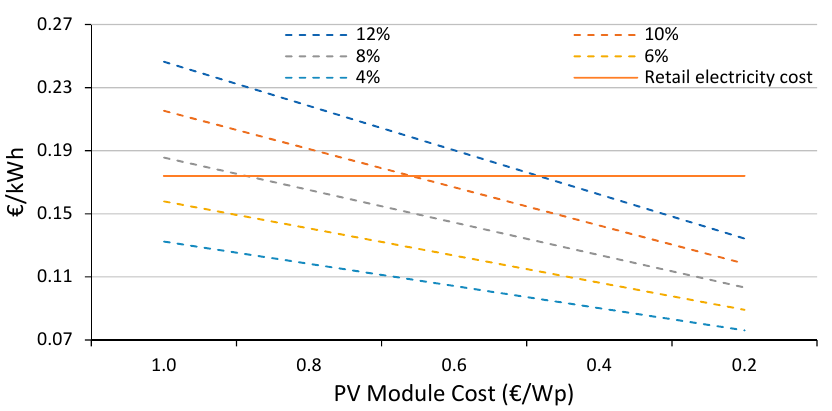
PV Module Cost (€/Wp)